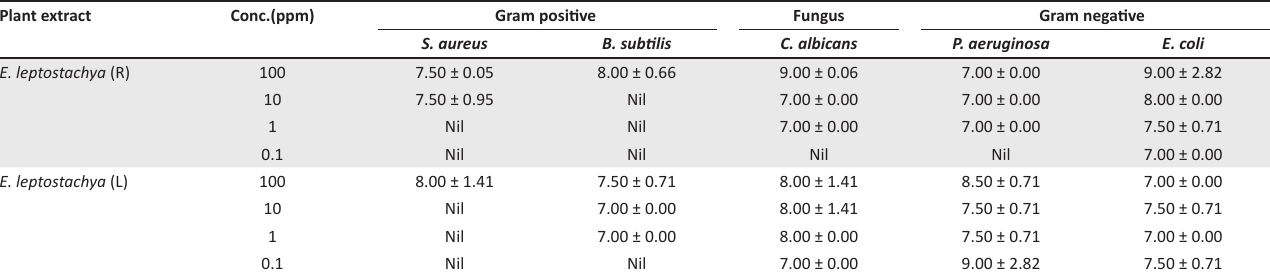
TABLE 5: Zone of inhibition of E. leptostachya (roots and barks). Plant extract